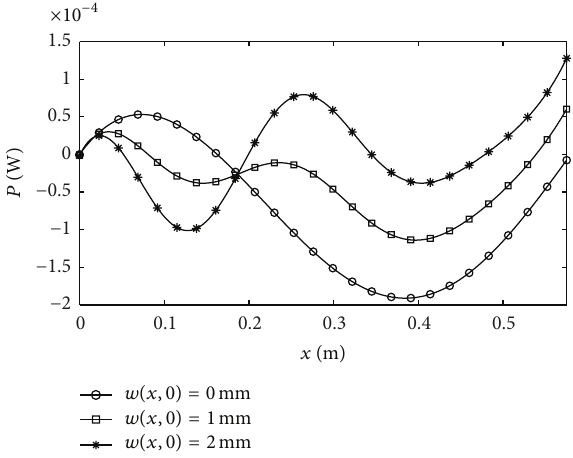
Figure 9: Vibration power flow of the FRMEJ with different modules under disturbance excitations.